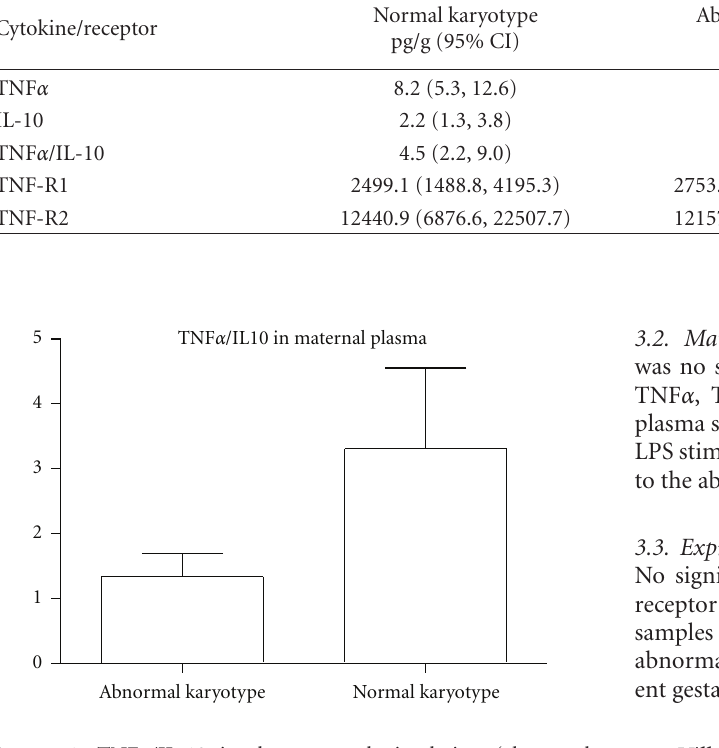
Figure 1: TNF α /IL-10 in the maternal circulation (abnormal karyotype, n = 14; normal karyotype, n = 12). There was a significantly ( P < 0 . 05) lower TNF α /IL-10 ratio in the plasma of miscarriages of abnormal karyotype than in those with normal